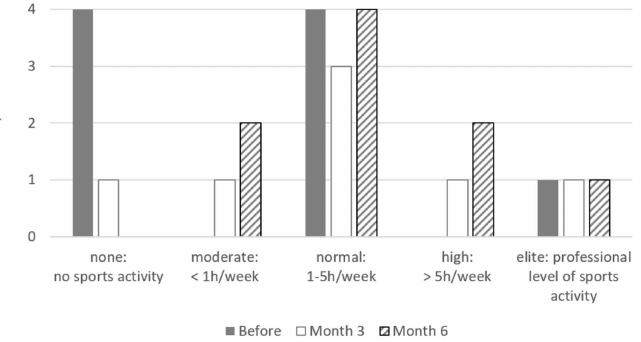
Figure 6. Sports frequency score before therapy, and after three and six months of